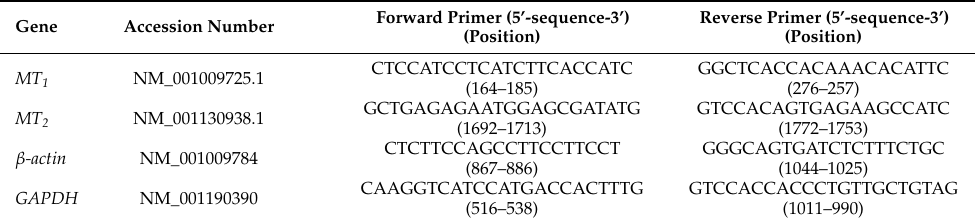
Table 1. Sequences of the MT 1 , MT 2 , β -actin , and glyceraldehyde-3-phosphate dehydrogenase GAPDH primers used in the real-time polymerase chain reaction (qPCR)